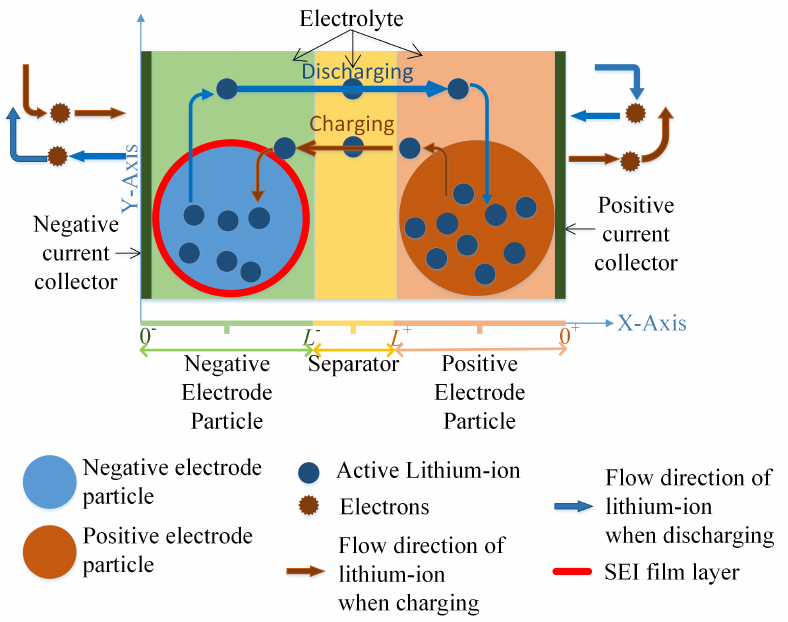
Figure A1. Single particle model (SPM) cell anatomy of the Li-ion